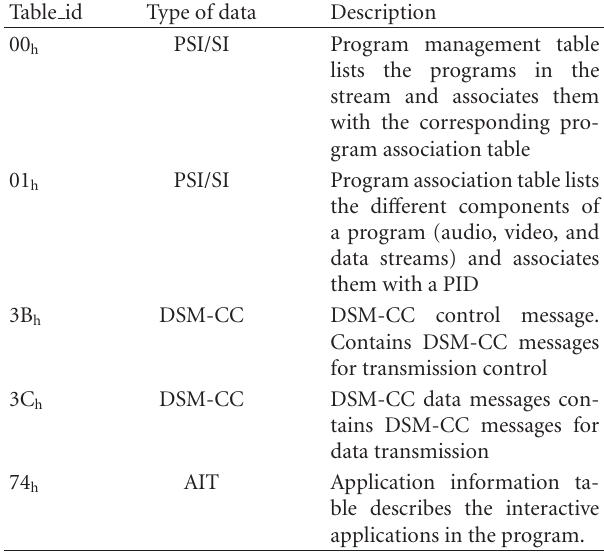
Table 2: Table id for di ff erent types of sections. Table